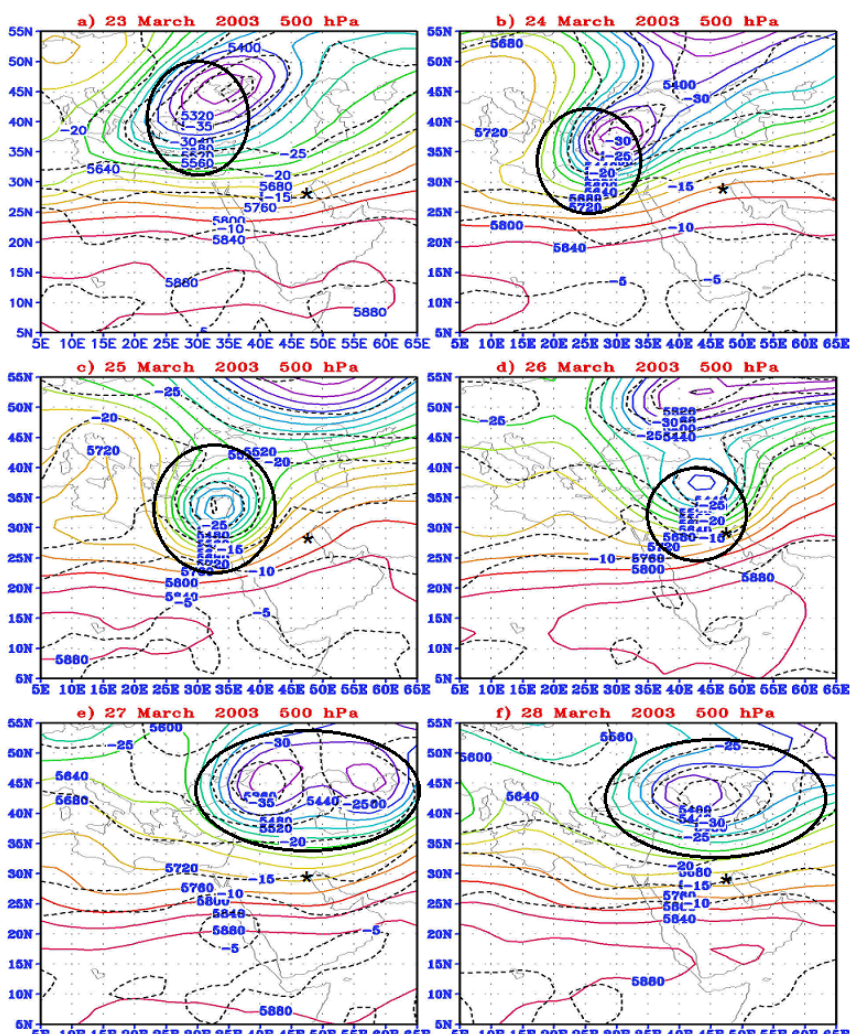
Fig. 3. Contour lines (solid lines) and isotherms (dotted lines) at 500mb for the period of 23–28 March 2003. The star symbol ( ∗ ) indicates the location of